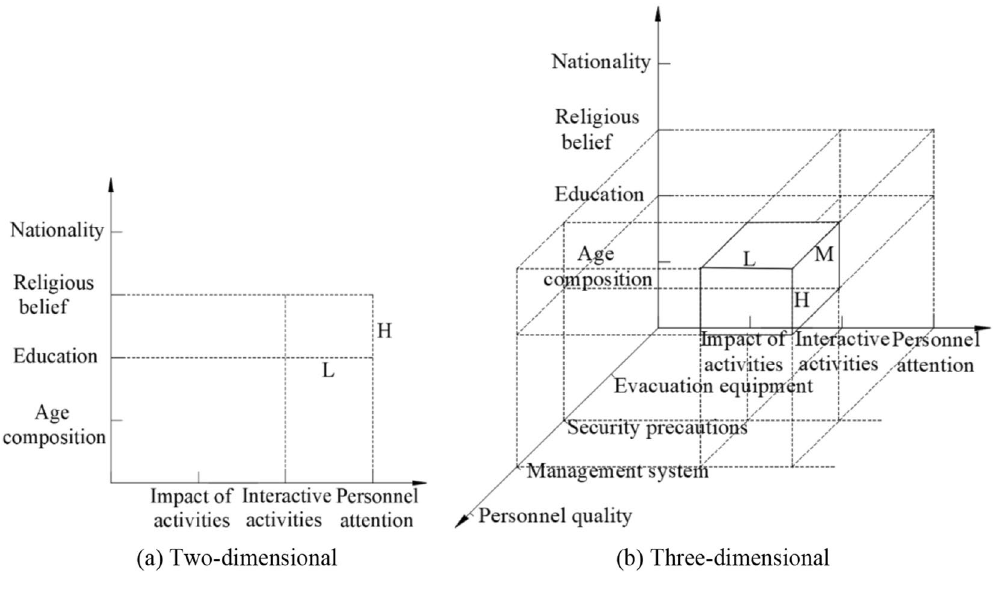
Figure 2. Risk scenario coupling